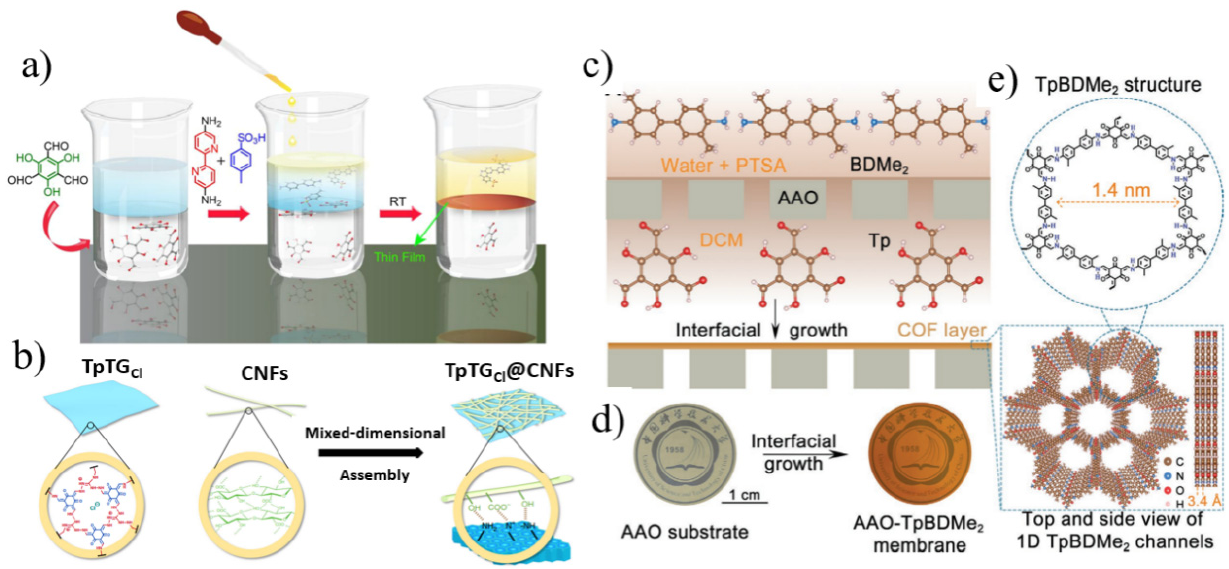
Figure 3. ( a ) Scheme of fabricating COF membranes by a liquid − liquid IP method. The bottom colorless layer, the blue layer, and the top yellow layer correspond to aldehyde in dichloromethane solution, water as the spacer solution, and amine-p-toluene sulfonic acid aqueous solution, respec- tively. ( b ) Scheme of mixed-dimensional assembly of COF nanosheets and CNFs. ( c ) Schematic of preparation of TpBDMe 2 membranes by an interfacial growth. ( d ) Photographs of AAO substrate and AAO supported TpBDMe 2 membranes with a diameter of ≈ 2 cm. ( e ) The structure of TpBDMe 2 membranes with 1D nanochannels of 1.4 nm and hydrogen bonding sites (-NH) on the channel wall. Reprinted with permission from [40,43,44]. Copyright (2017) American Chemical Society.